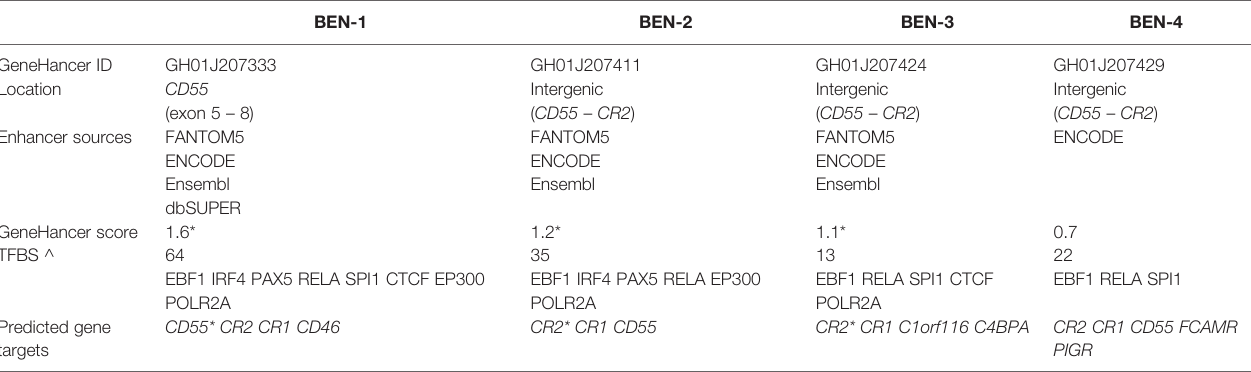
TABLE 1 | Candidate B cell enhancers (BENs) on GeneHancer were identi fi ed from multiple enhancer databases, contained numerous transcription factor binding sites (TFBS) and were predicted to regulate several